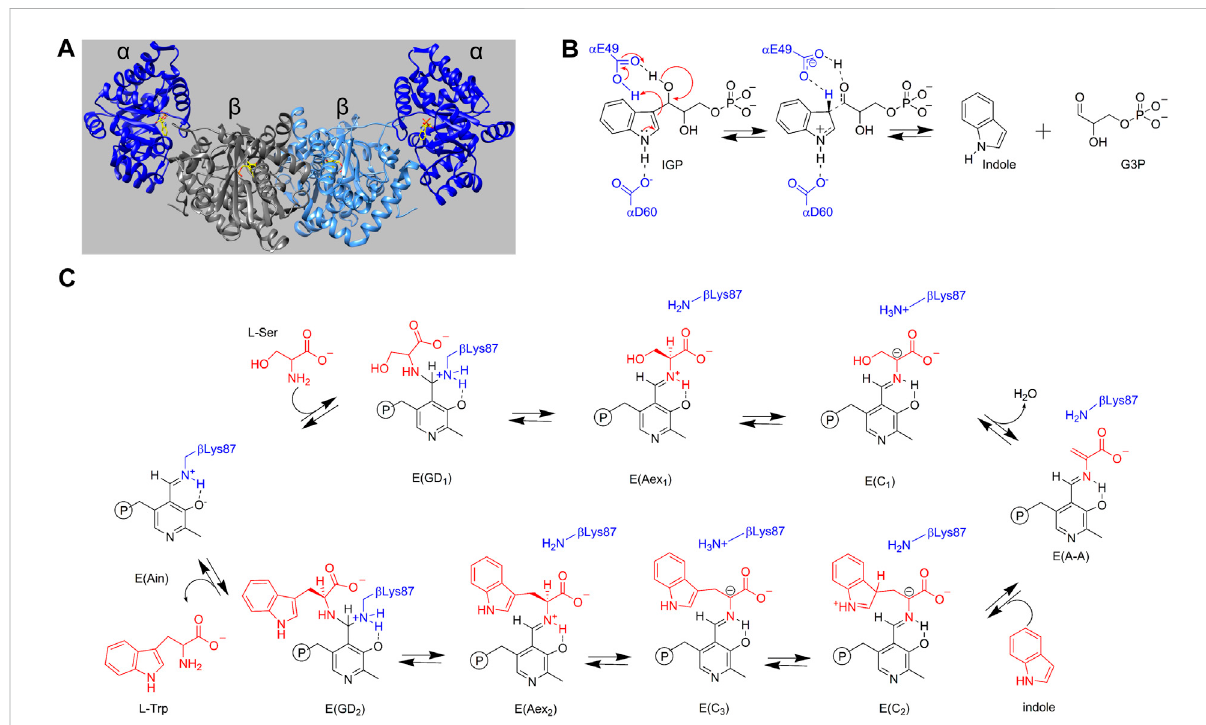
FIGURE 1 (A) Three-dimensional structural representation of the α 2 β 2 tryptophan synthase hetero-tetrameric multienzyme complex from S. typhimurium . α -Subunitsdarkblue, β -subunitsgrayandlightblue.Thesubstrateforthe α site,3-indoleD-glyceraldehyde3 ′ -phosphate,andthePLP cofactor as the internal aldimine covalently attached to β Lys87 at the β -site are shown with yellow carbons. PDB ID: 2RHG. (B) α -Reaction with catalytic residues α Glu49 and α Asp60 shown in blue. (C) β -Reaction with the reacting substrates L-Ser and indole and product L-Trp shown in red. Catalytic residue β Lys87 is shown in blue. PLP species are shown in black and reacting substrate species are shown in